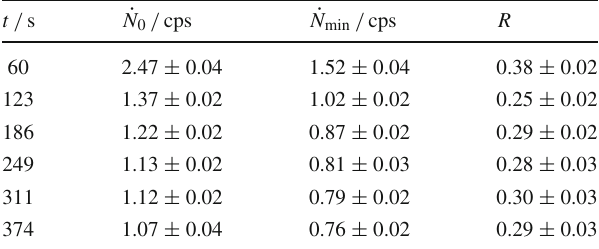
Table 2 Electron removal by the magnetic pulse with a 83m Kr source. The table shows the observed electron rate in the low-energy regime before and after a magnetic pulse, and the time t of each pulse after start of the measurement. The removal efficiency R in each pulse cycle was computed via Eq.